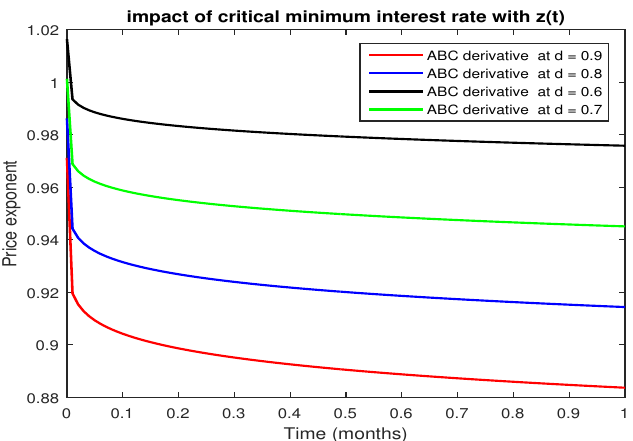
Figure 13. Impact of critical minimum interest rate with z ( t )